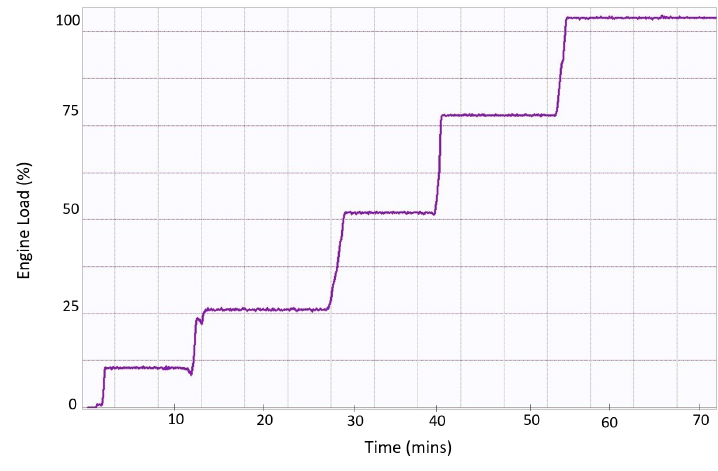
Figure 12. Real-time engine load